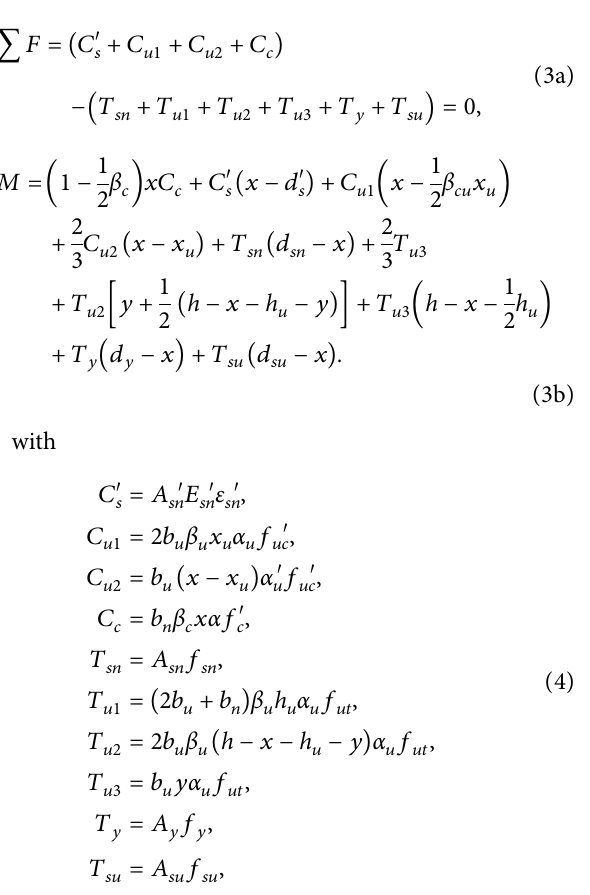
Figure 8: Description of the fexural model. (a) Cracking stain and stress distribution. (b) Stain and stress distribution at failure